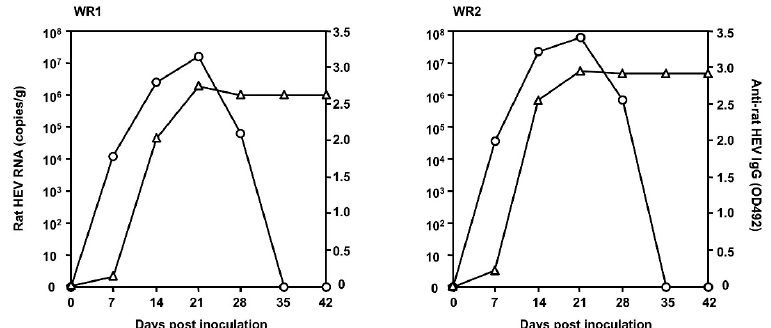
Figure 3. Infectivity of the rat HEV recovered from the culture supernatant. Two Wistar rats (WR1 and WR2) were inoculated with the S1129-infected culture supernatant collected on day 168. After inoculation, fecal samples were collected two times / week, and serum samples were collected weekly until 7 weeks. Rat HEV RNA in the stool was monitored by RT-qPCR ( IgG ( ∆ ) antibodies were detected by